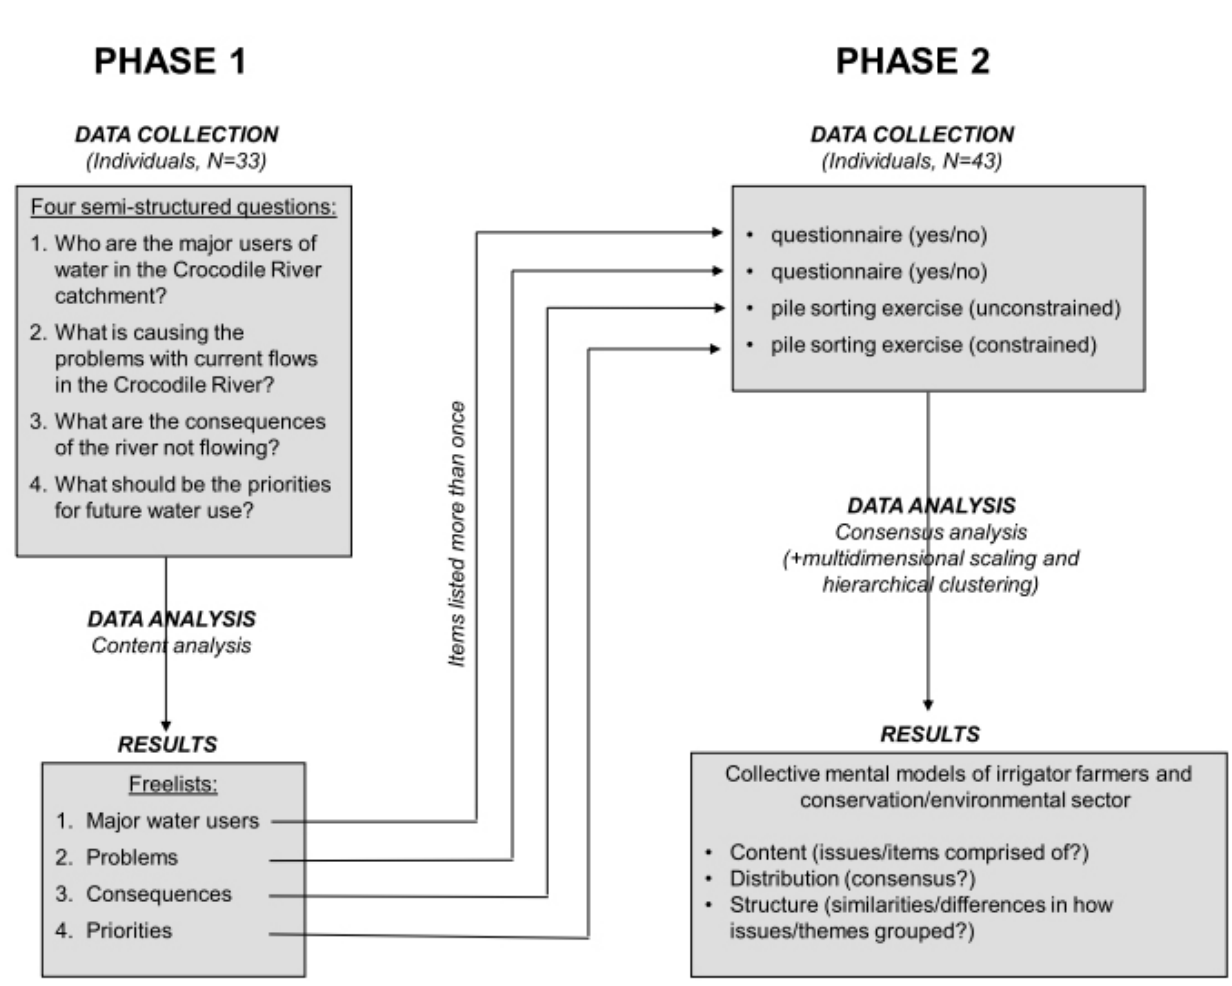
Fig. 2 . Phases of data collection and analysis, for Crocodile River catchment